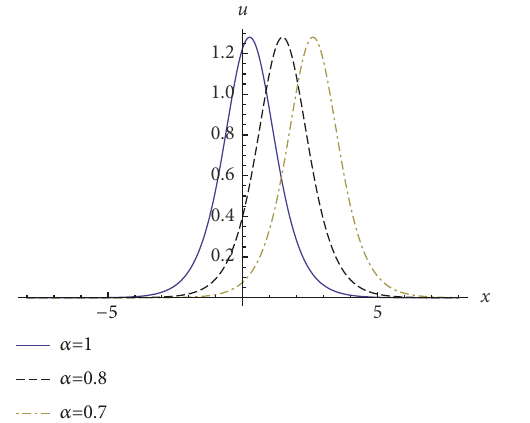
Figure 1: Fractional one-solitons determined by solution (43) at time 𝑡 = 1 .